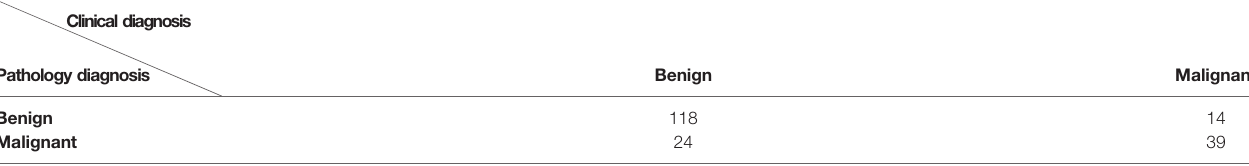
TABLE 3 | The sensitivity and speci fi city of clinical diagnosis for malignant gallbladder polypoid-lesions were 0.6190 and 0.8939, respectively. Clinical diagnosis